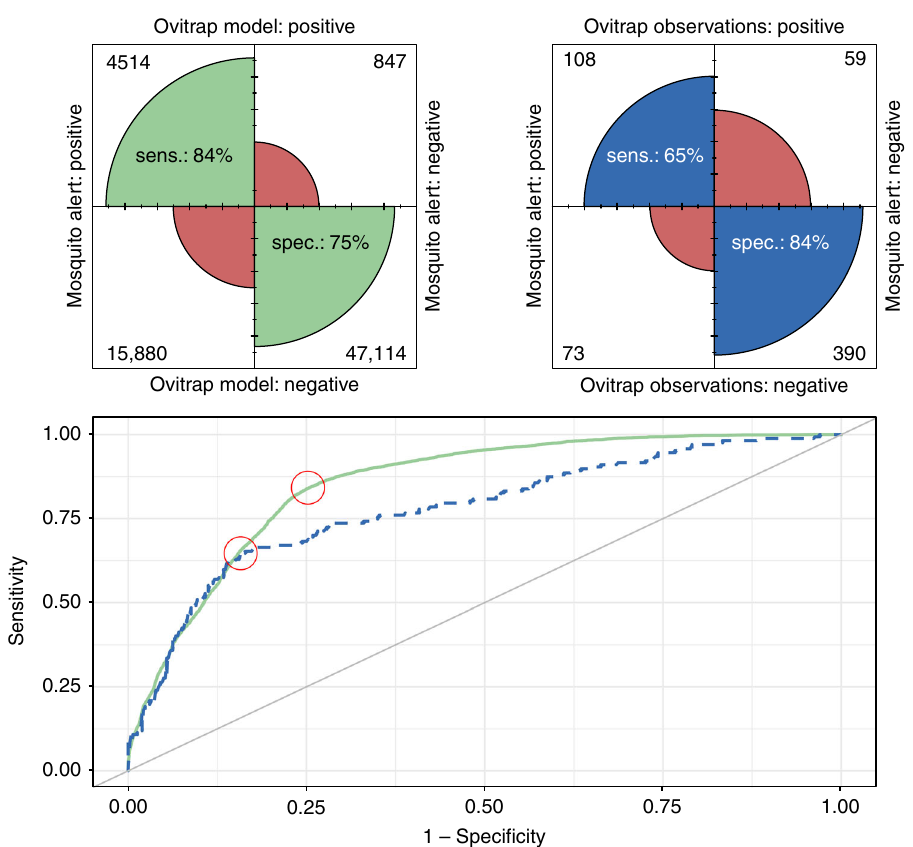
Fig. 6 Receiver operating characteristic (ROC) curves (bottom) and confusion matrix plots (top) for Mosquito Alert human – mosquito encounter probability model predictions. Bottom: ROC curves show trade-off between sensitivity and speci fi city of biweek municipality predictions depending on the threshold used for predictions, with the area under the curve (AUC) providing a measure of classi fi er performance that is insensitive to changes in class distribution. Plot shows Mosquito Alert predictions of biweek municipal-level ovitrap model predictions (solid green line; AUC = 0.85) and observations (dashed blue line; AUC = 0.78). Diagonal line shows AUC = 0.50, which is the theoretical value for random guessing. Top: confusion matrix plots drawn using the thresholds that maximize the sum of sensitivity and speci fi city for the ROC curve drawn from the ovitrap model (left) and observed ovitraps (right). This threshold is indicated on the ROC curves themselves (bottom plot) with red